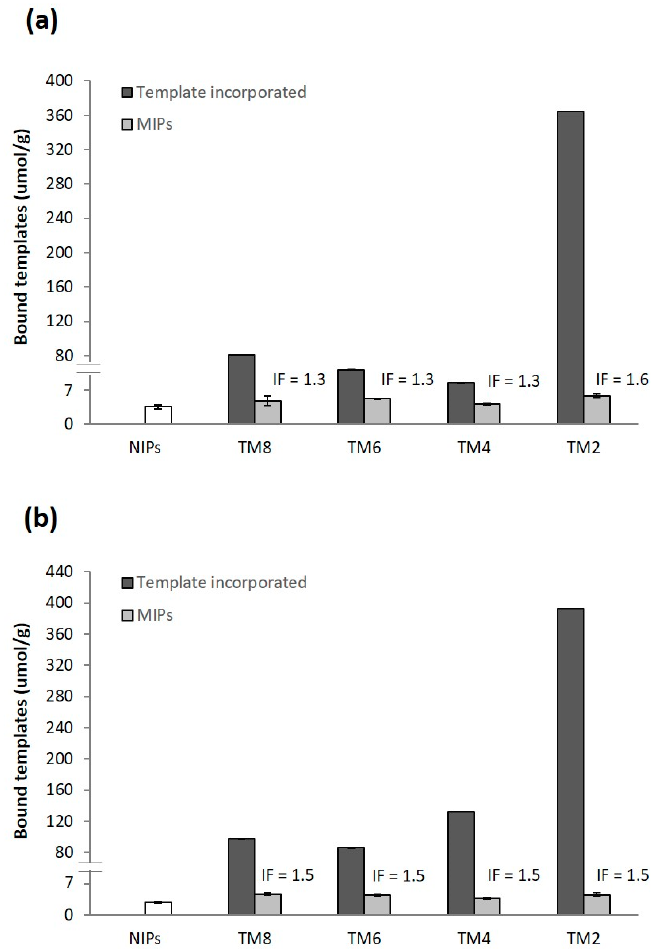
Figure 3. Template incorporation and binding of ( a ) CAF and ( b ) THP MIPs and NIPs synthesized at various T:fM ratios. Polymers were incubated for 18 h in 100 µM template rebinding solution with 70–90% binding from the rebinding solution. Post rebinding solutions were analysed by HPLC. Template incorporation in µmol/g is also shown for comparison purposes.